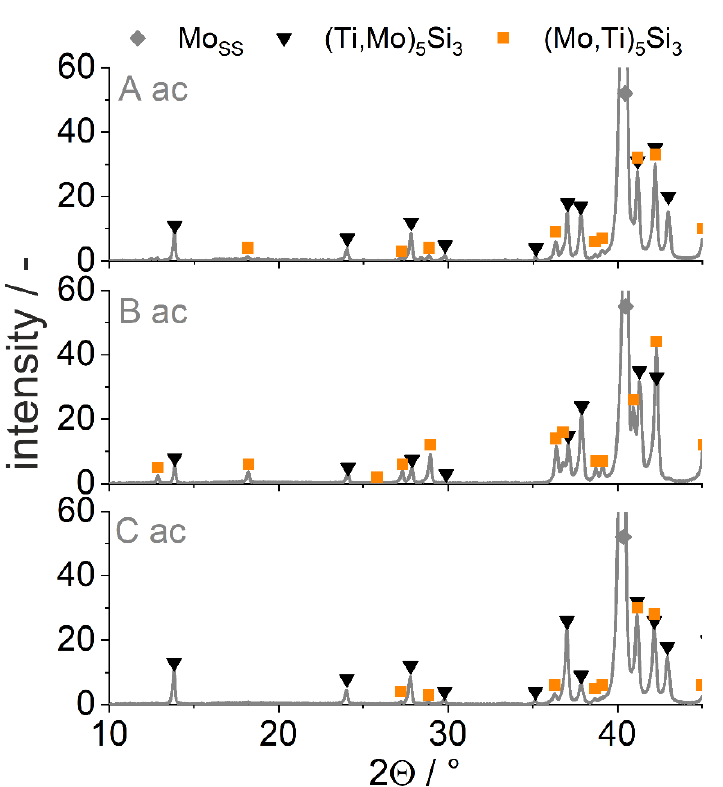
Figure A1. XRD pattern of the investigated alloys A to C in as-cast condition. Bcc Mo SS is highlighted by grey diamonds, hexagonal D8 8 (Ti,Mo) 5 Si 3 by black triangles and tetragonal (Mo,Ti) 5 Si 3 by orange squares.